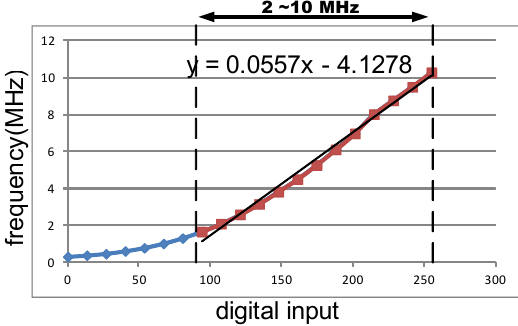
Figure 19. Curve of frequency versus counter’s count generated by OTA-C oscillator.